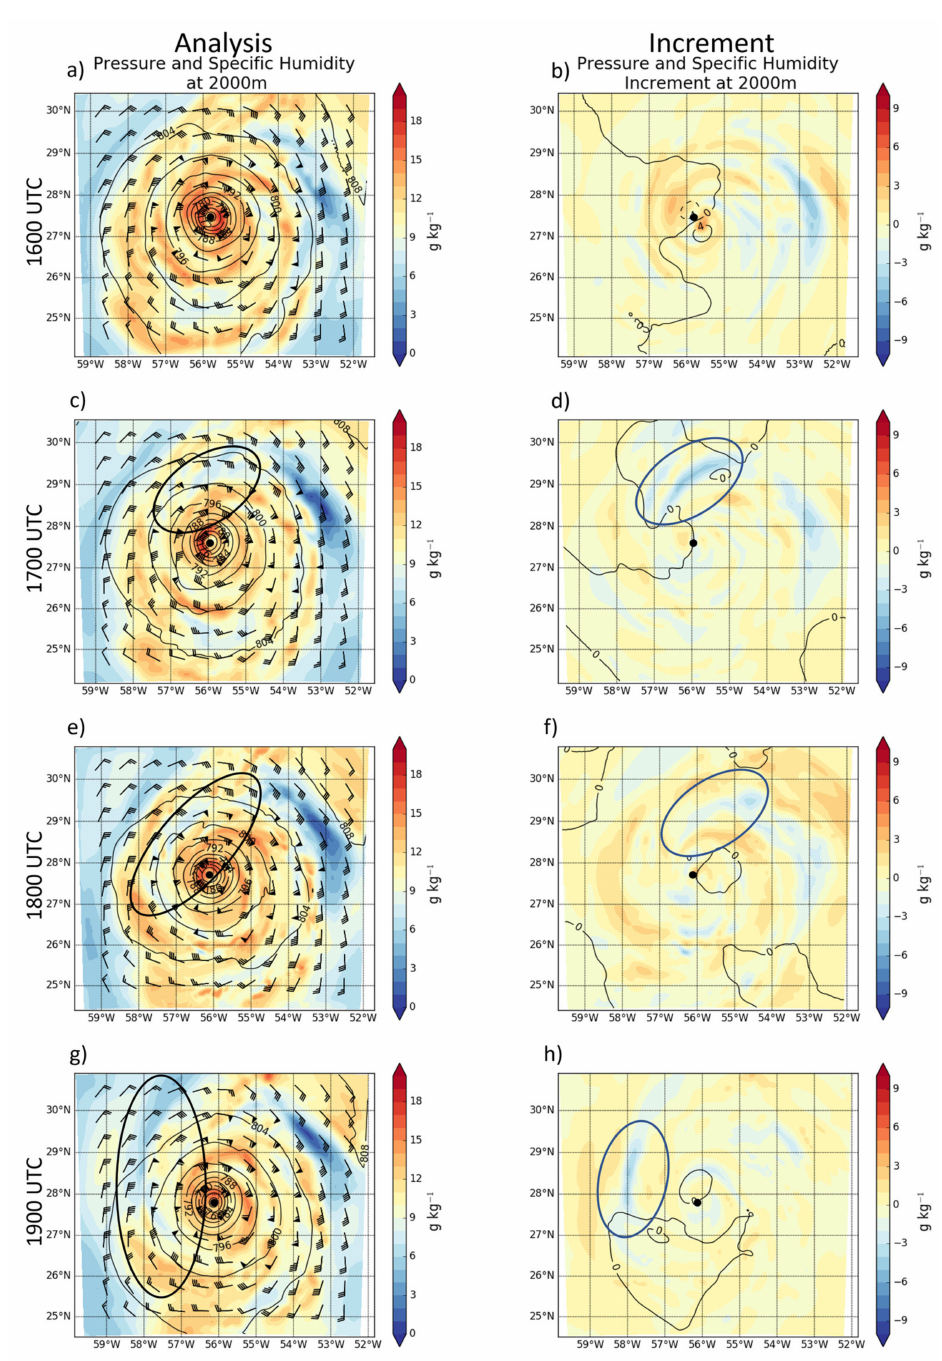
Figure 10. Left column: Specific humidity analysis (colors) for E2 1H-3DEnVar at ( a ) 1600 UTC, ( c ) 1700 UTC, ( e ) 1800 UTC, and ( g ) 1900 UTC with pressure (contours) every 4 hPa and wind barbs overlaid. Regions of new dry air and dry air advected during forecasts are circled. Right column: Specific humidity (colors) and pressure (contours) increments for E2 1H-3DEnVar at ( b ) 1600 UTC, ( d ) 1700 UTC, ( f ) 1800 UTC, and ( h ) 1900 UTC. The main regions of negative Q increments are